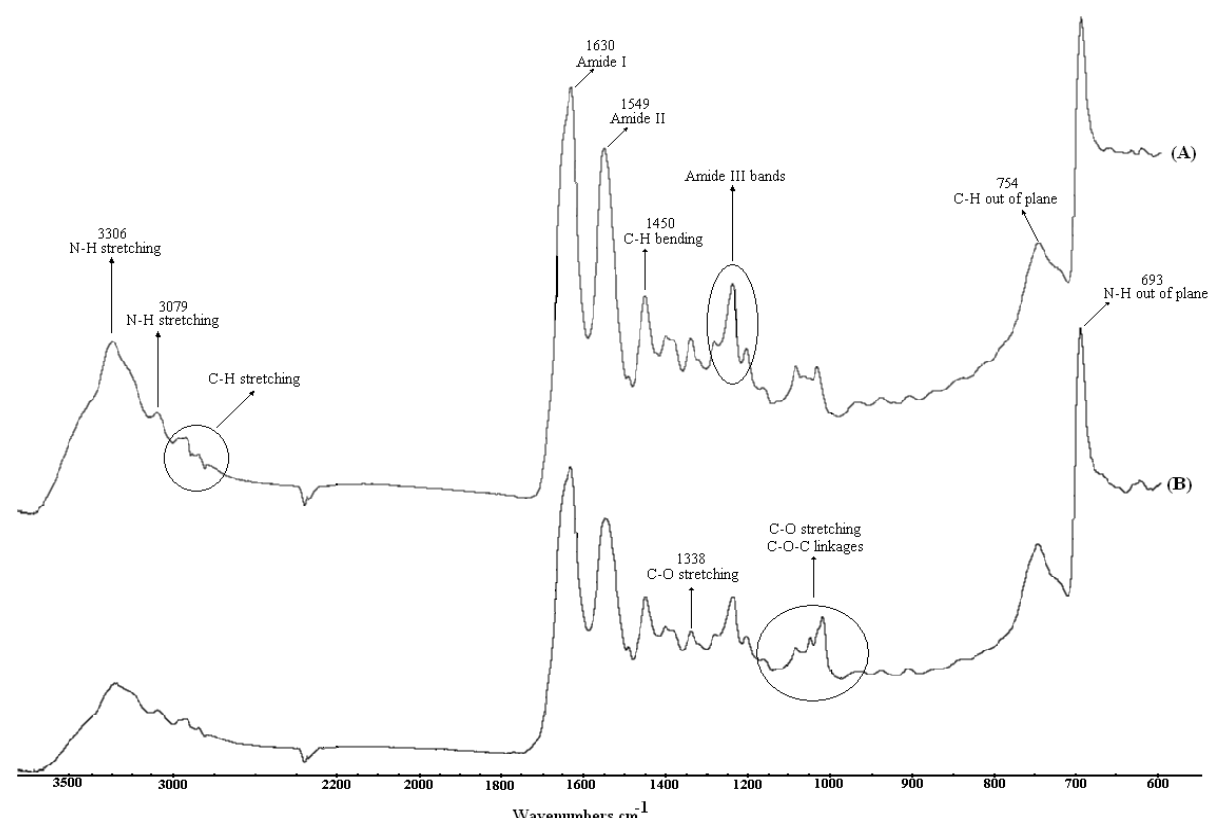
Figure 1. ATR-FTIR spectra of: (A) untreated and (B) argon plasma-treated films.